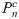
Critical network polarization as a function of opinion polarization.This graph shows how Pnc (the network polarization for which the highest virality is reached) depends on Po (the opinion polarization of the cluster). Comparing to Fig 3, this shows the network and opinion polarization at each point at which virality peaks. As the graph shows, the optimal echo chamber has more external connections and fewer internal connections as Po increases. In the control (dashed line), there is no interaction effect between network and opinion polarization.